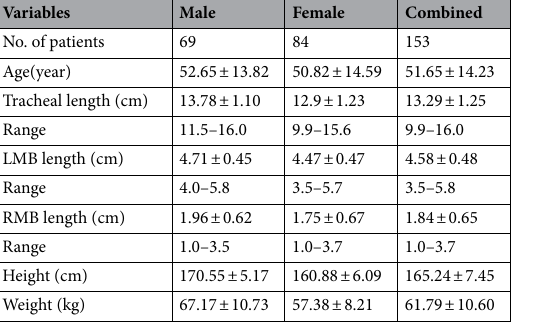
Table 1. Characteristics and lengths of trachea and bronchus in adult patients. LMB left main bronchus, RMB right main bronchus.